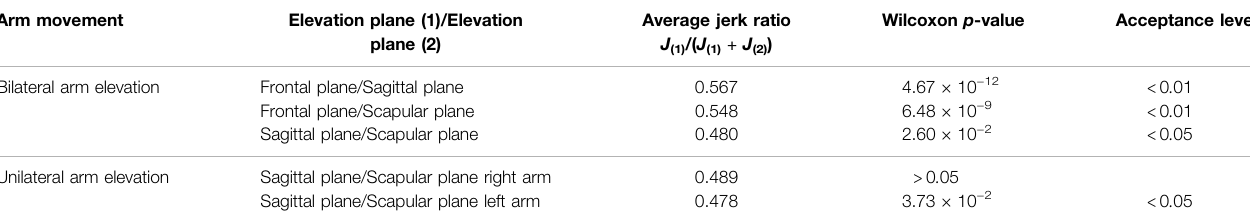
TABLE 6 | Comparisons of jerk metrics between the different planes during bilateral and unilateral arm elevation. Arm